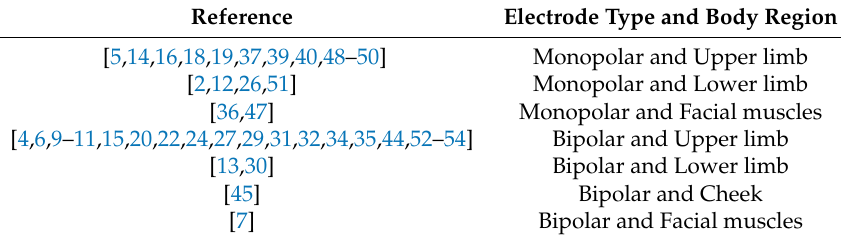
Table 4. Electrodes type and place of electrode placement